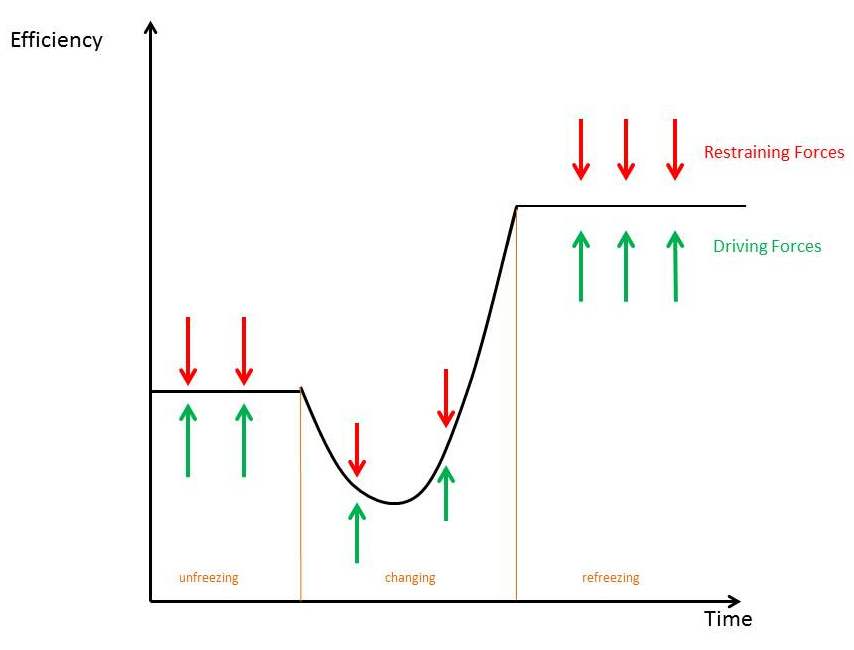
Figure 1. Lewin’s field model (own diagram following [24]).